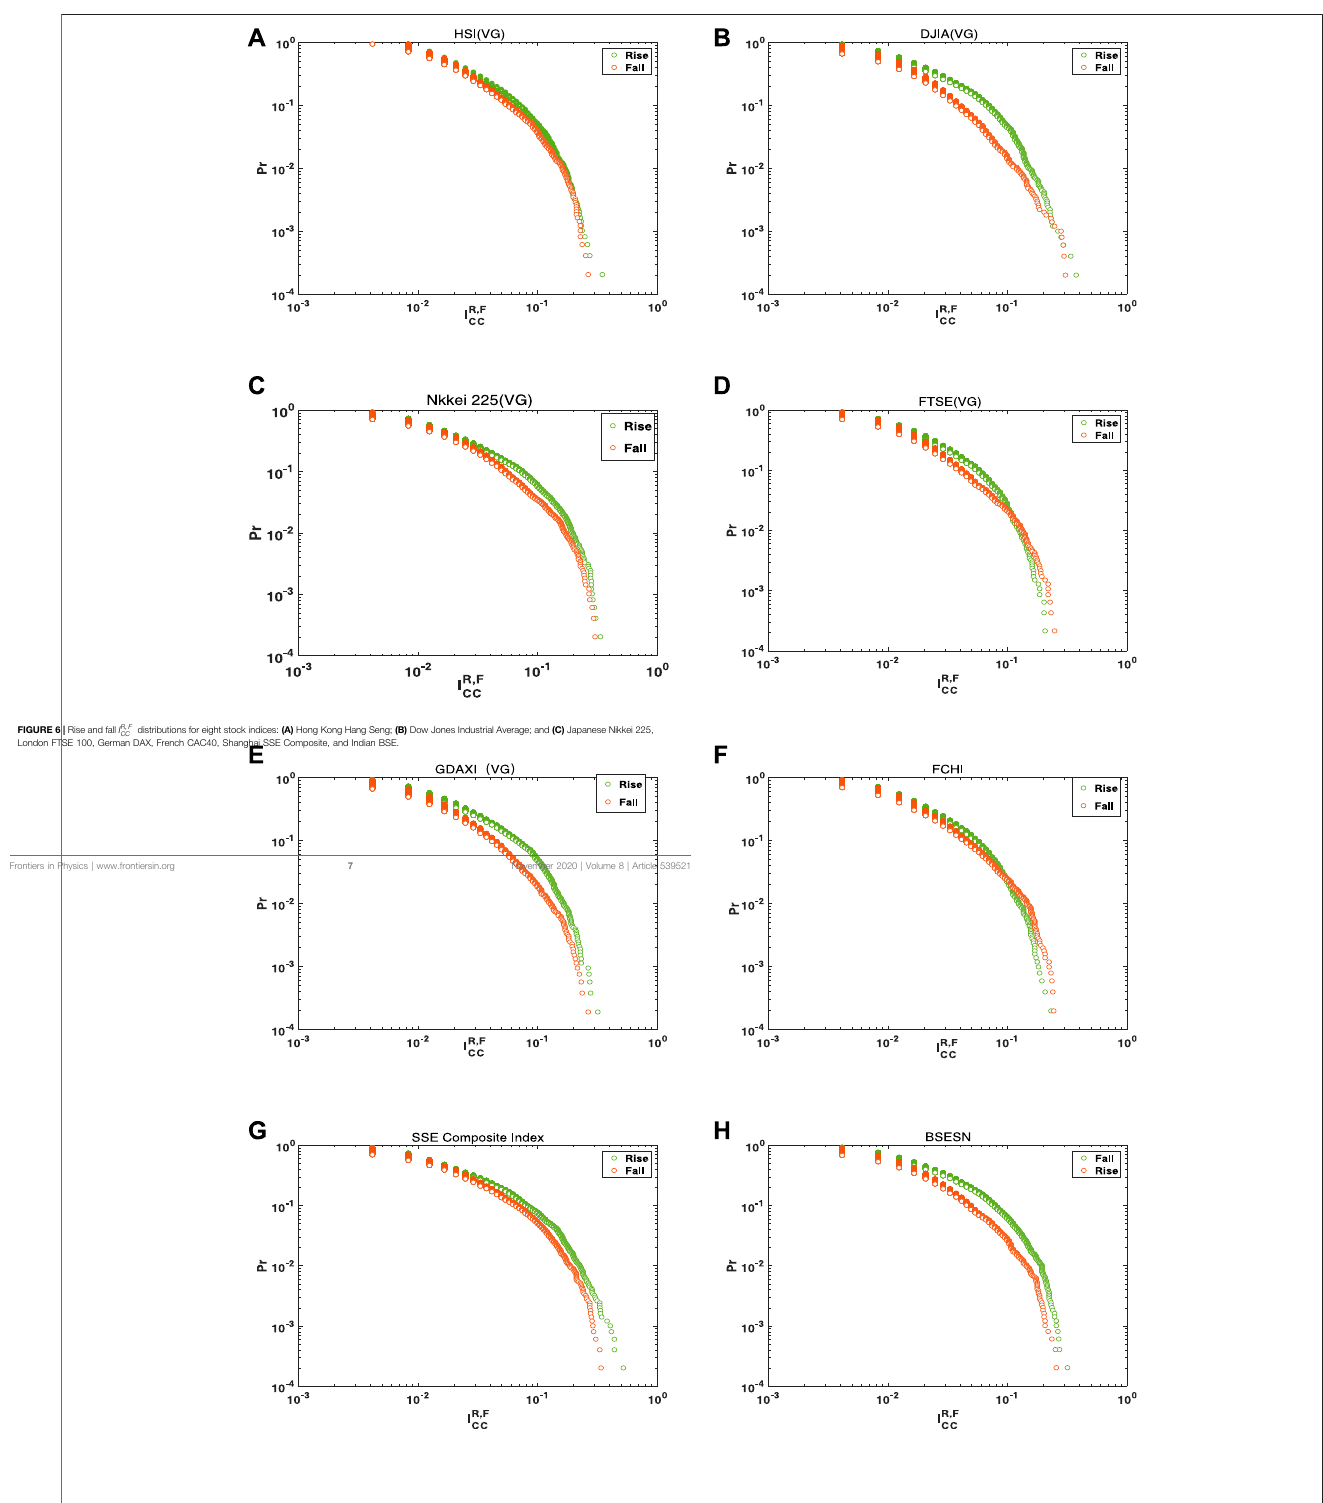
FIGURE6| Riseandfall I R , FCC distributionsforeightstockindices: (A) HongKongHangSeng; (B) DowJonesIndustrialAverage;and (C) JapaneseNikkei225, LondonFTSE100,GermanDAX,FrenchCAC40,ShanghaiSSEComposite,andIndianBSE.